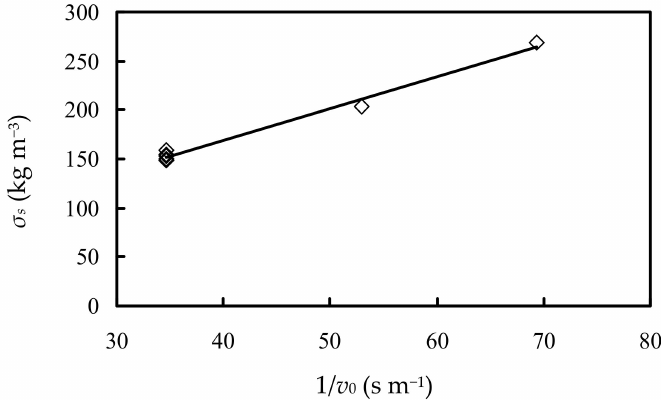
Figure 6. σ s vs. 1/ v 0 for the solution containing M-PVAC-IDA using HGM separator (HGF-10 1).